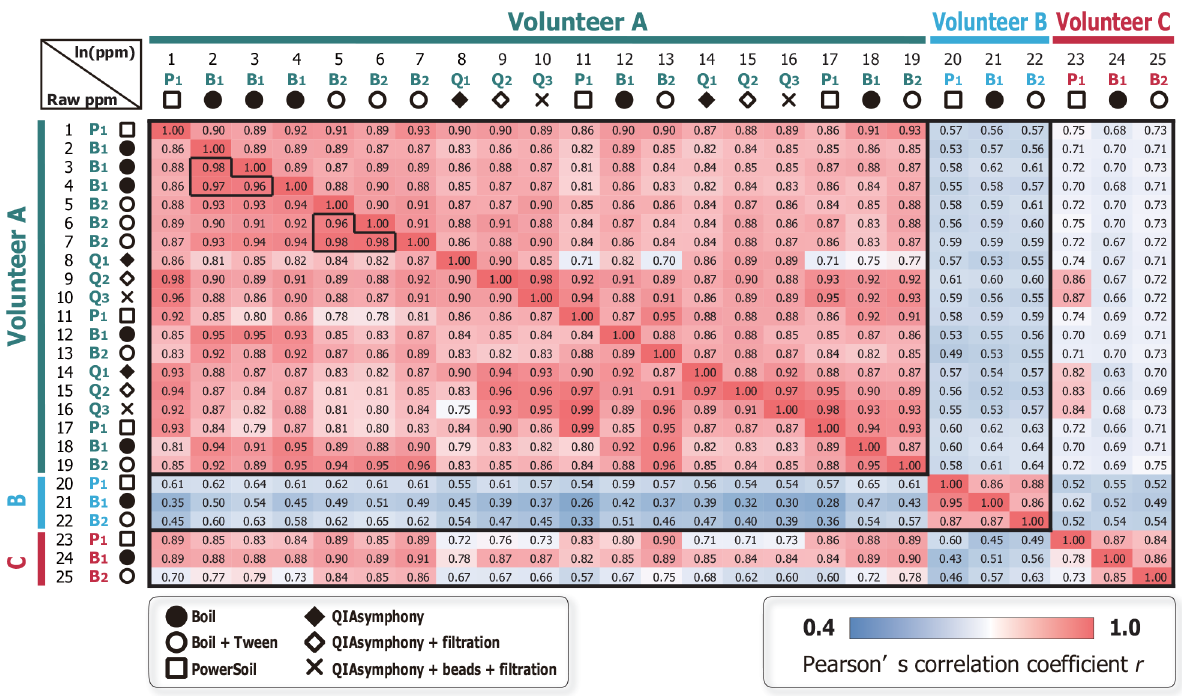
Fig 2. Correlation coefficient ( r ) matrix among assigned microbes for each sample. Upper right half represents correlation coefficients based on a logarithm-converted value. Lower left half represents those on linear value. Descriptions of each sample are shown in Table 1 and Fig